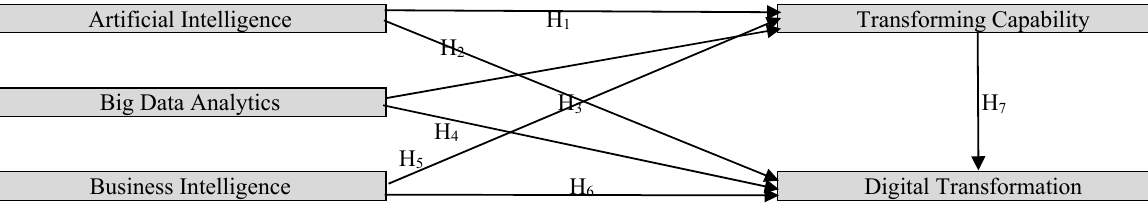
Fig. 1. Conceptual of the proposed method